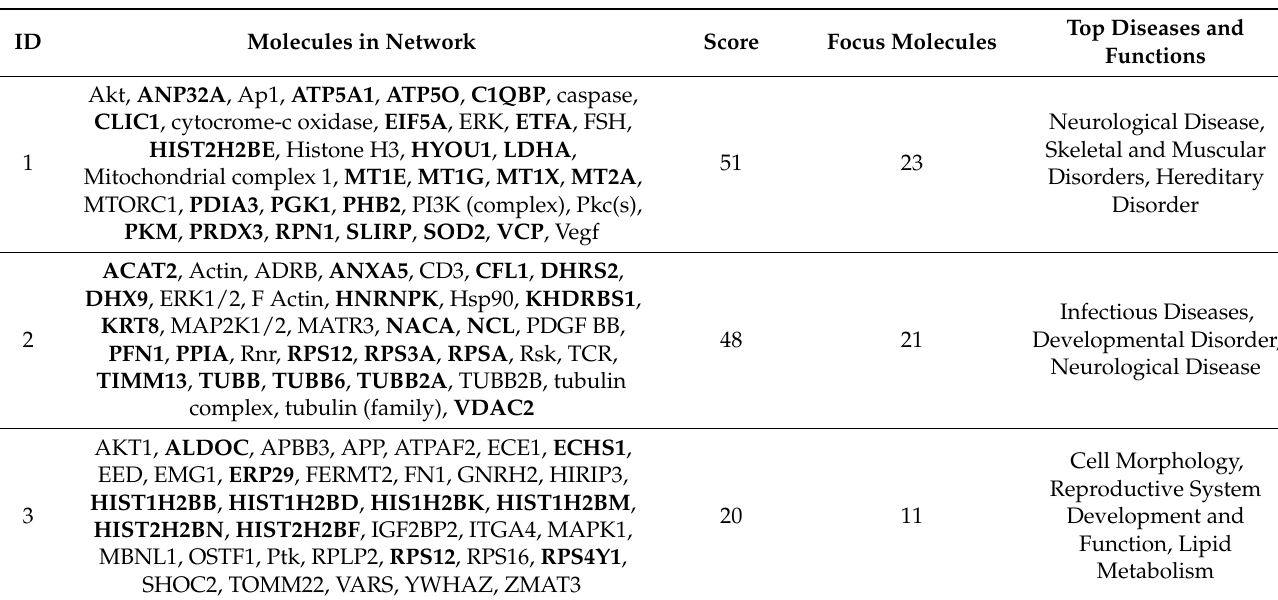
Table 2. The top five biofunctions with their respective IPA